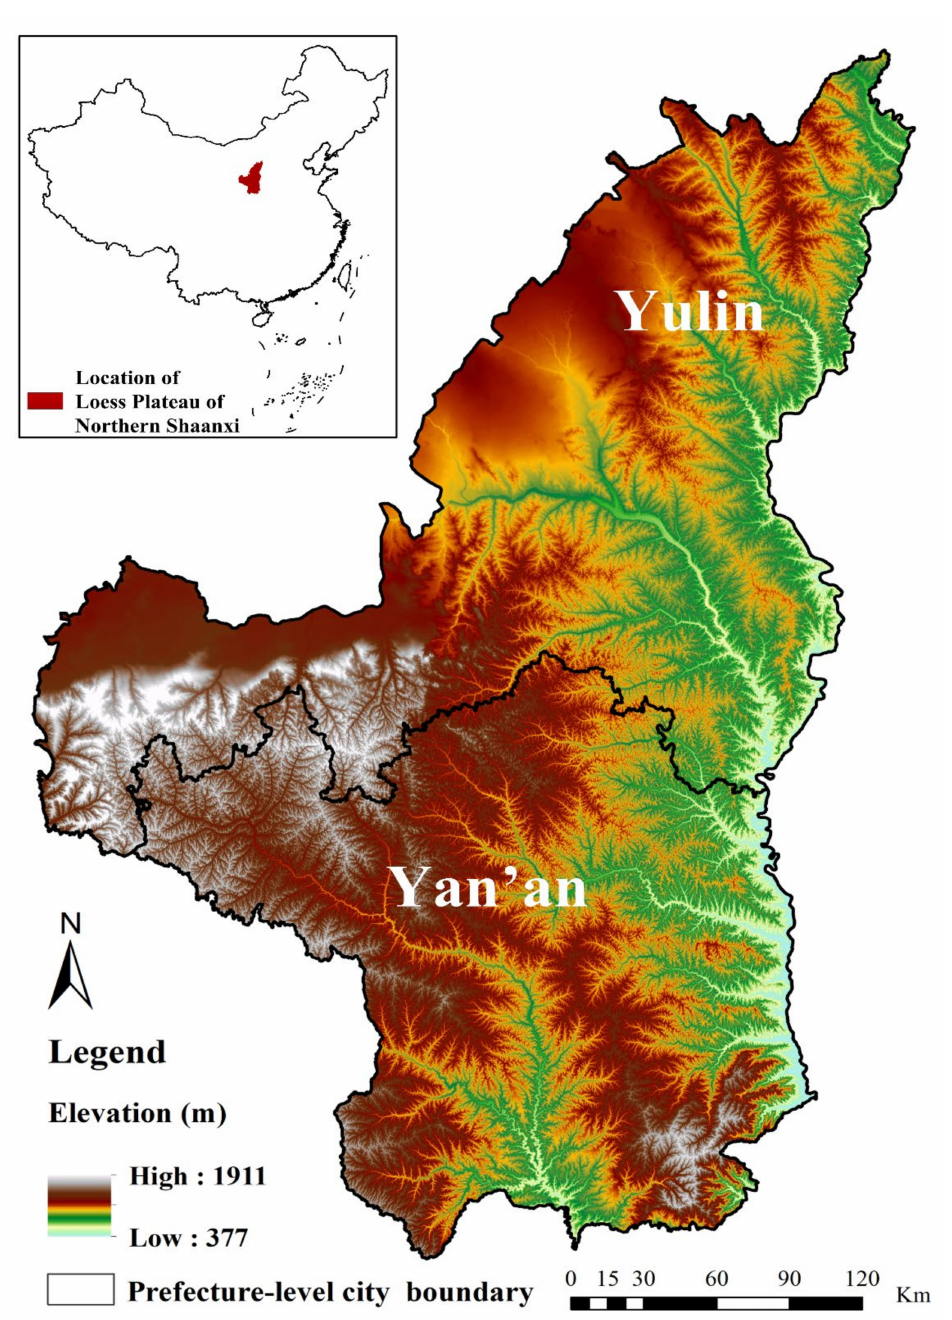
Figure 1. Location and elevation map of the study